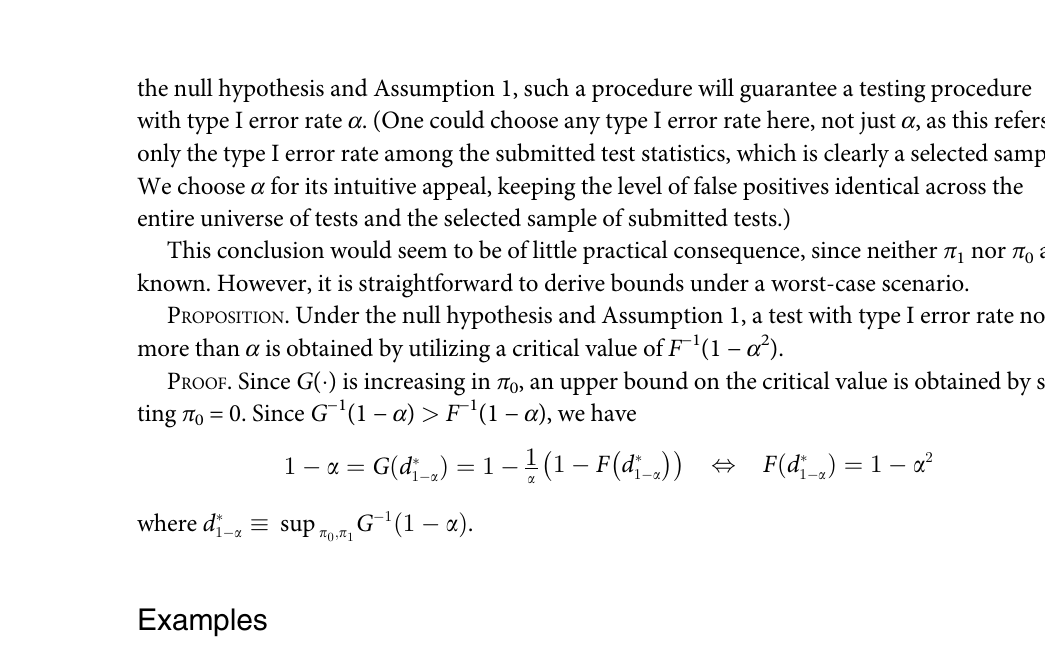
Table 1 lists unadjusted and adjusted critical values for selected tests, where the adjusted critical values are those of the proposition. As discussed, under a satisficing model of publication bias, use of these critical values guarantees that the tests have type I error rate of at most 5 percent. The tests considered are two-tailed t-tests, F-tests with 5 and 10 numerator degrees of freedom and a large denominator degrees of freedom, and two types of nonparametric two-sample tests (Kolmogorov-Smirnov and Feller). All tests are of the form “ reject if T > c . some c 1 − α